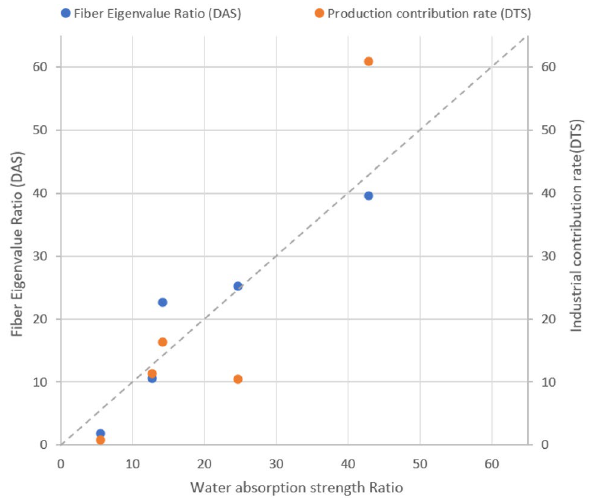
Fig. 7 Error analysis diagram